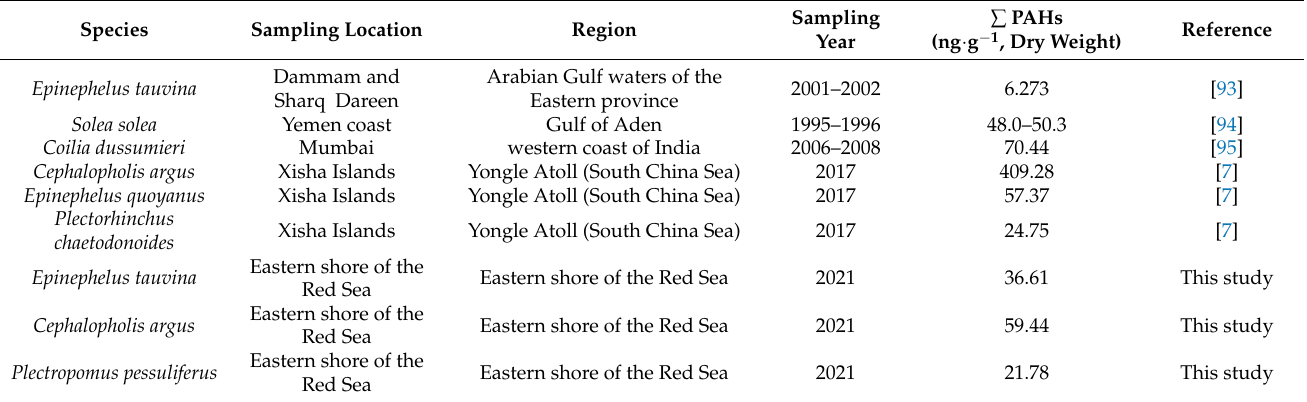
Table 9. Comparison of PAH levels with results from other studies from Saudi Arabia and other countries.